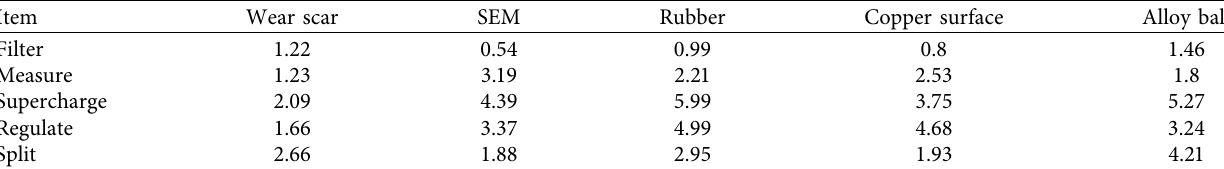
Table 4: Wear marks on polycrystalline diamond disc.